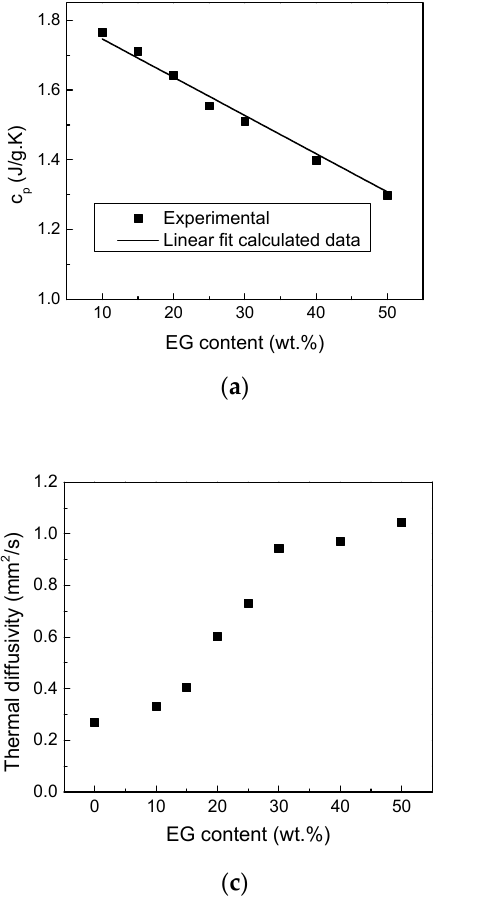
Figure 2. ( a ) experimental and calculated c p of HDPE, and EG composites by weight, ( b ) thermal conductivity of HDPE and EG composites and ( c ) thermal diffusivity of HDPE and EG composites.